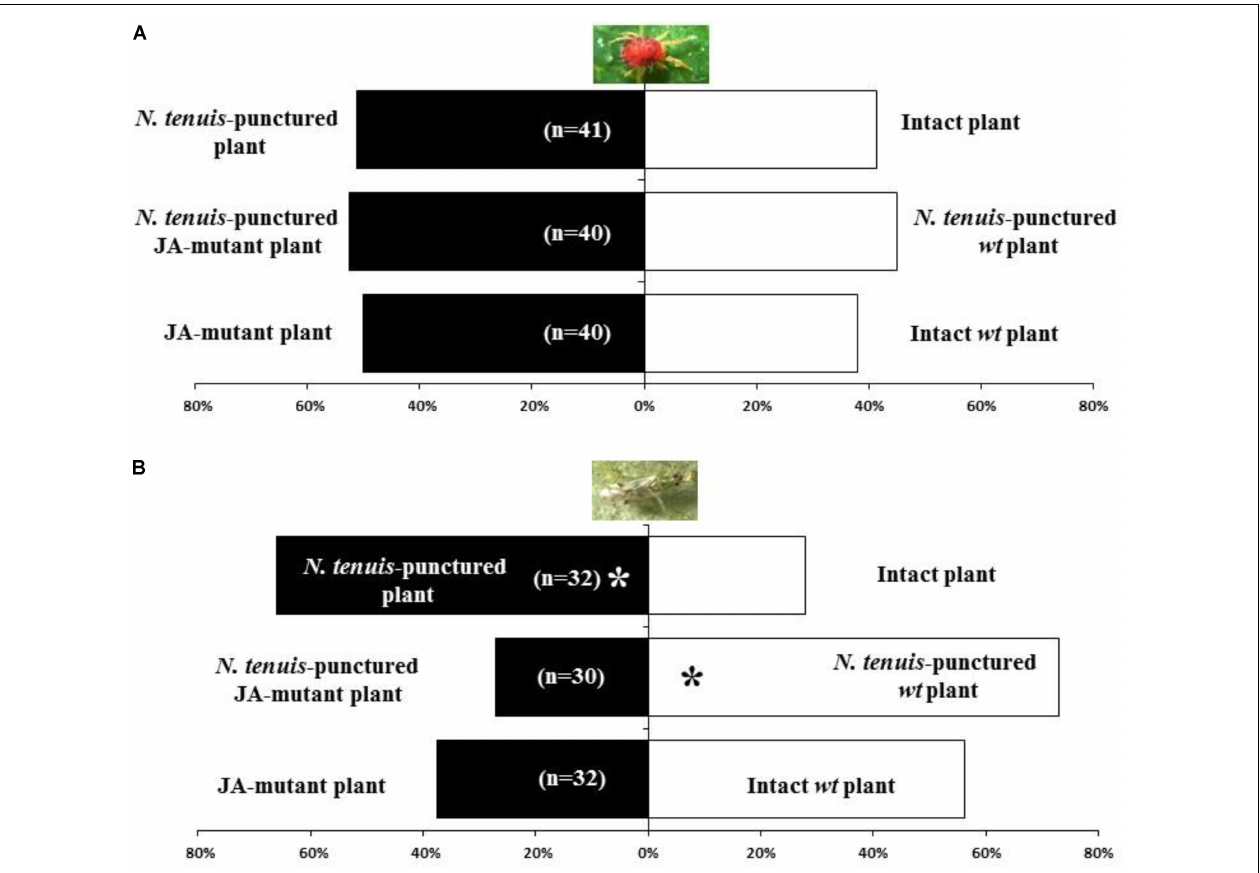
FIGURE 1 | Response of the herbivore T. urticae females (A) and the natural enemy Nesidicoris tenuis (B) in a Y-tube olfactometer when exposed to JA-deficient mutant tomato plants or their near isogenic wild type (wt plant), which were with the zoophytophagous Nesidiocoris tenuis ( N. tenuis -punctured plants) or without (intact plants) contact with N. tenuis . Significant differences using a χ 2 test are marked with ∗ P < 0.001.